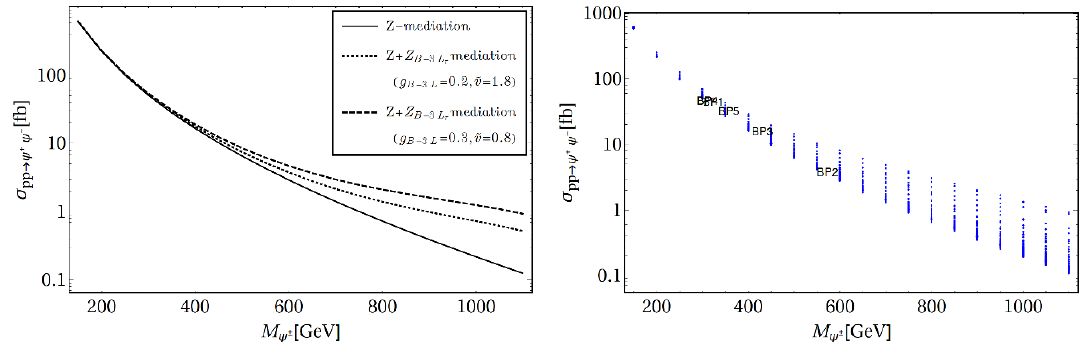
Figure 12 . Left: plot showing improvement in production cross-section of the charged VLF pair due to Z B (cid:0) 3 L mediation for two choices of f g B (cid:0) 3 L ; ~ v g : f 0 : 2 ; 1 : 8 g & f 0 : 3 ; 0 : 8 g shown in black (cid:28) (cid:28) dashed and black dotted curves respectively. Right: variation of (cid:6) pair production cross-section with M (cid:6) for g B (cid:0) 3 L ~ v varying in the range: f 0 : 05 ; 0 : 3 g and f 0 : 8 ; 5 : 5 g when both Z and Z B (cid:0) 3 L (cid:28) (cid:28) mediation are taken into account. The BPs tabulated in table 2 are also indicated in black. Note that BP1 and BP4 have almost overlapped because of similar production cross-section. All the p & 2 : 5 TeV. For both the plots s = 14 TeV is chosen with points on the scan satisfy m Z B (cid:0) 3 L(cid:28) CTEQ6l as parton distribution